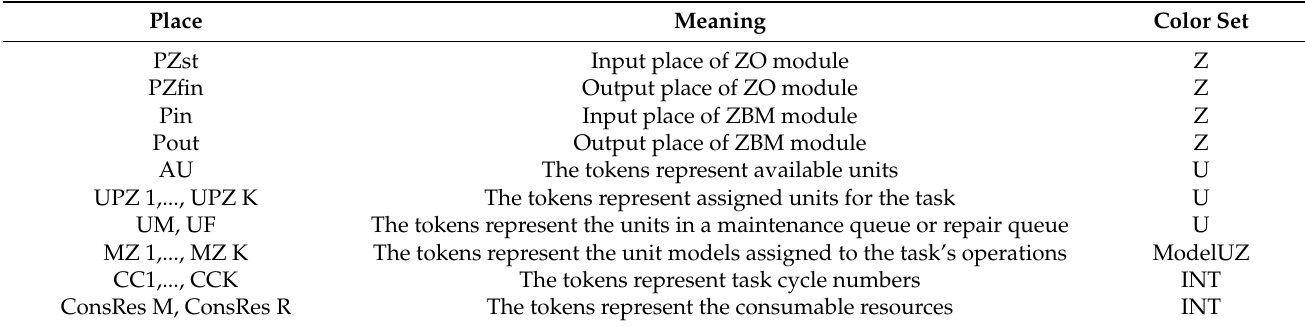
Table 2. ZO module